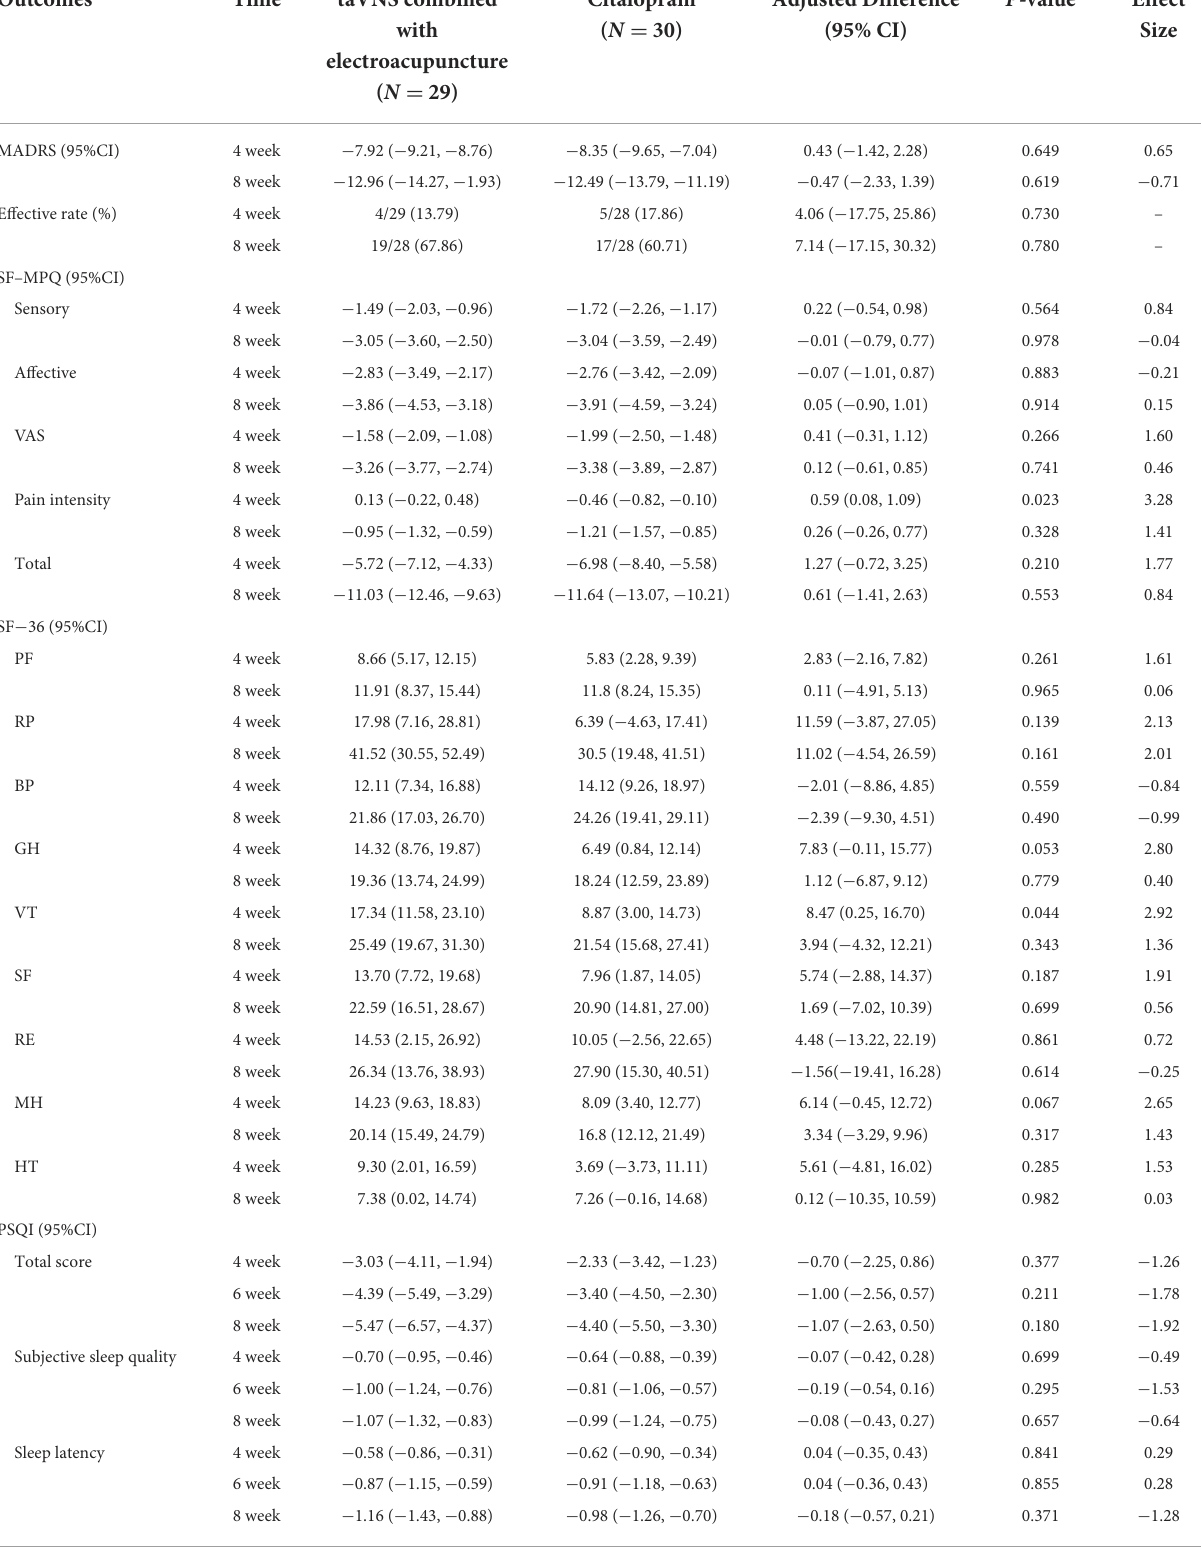
TABLE 2 Changes in baseline and endpoint data on outcome measures for the intent-to-treat